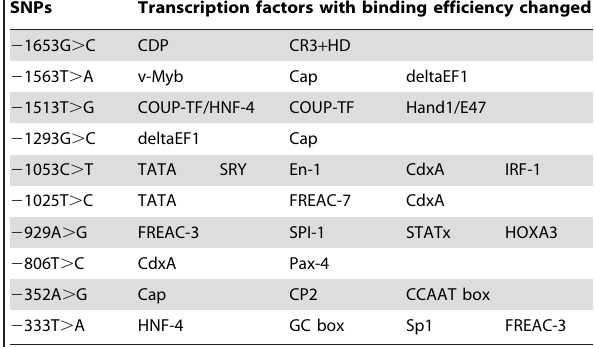
Table 3. Predictive analysis (performed by CONREAL) of transcription factor binding sites affected by potential regulatory SNPs in CYP2E1